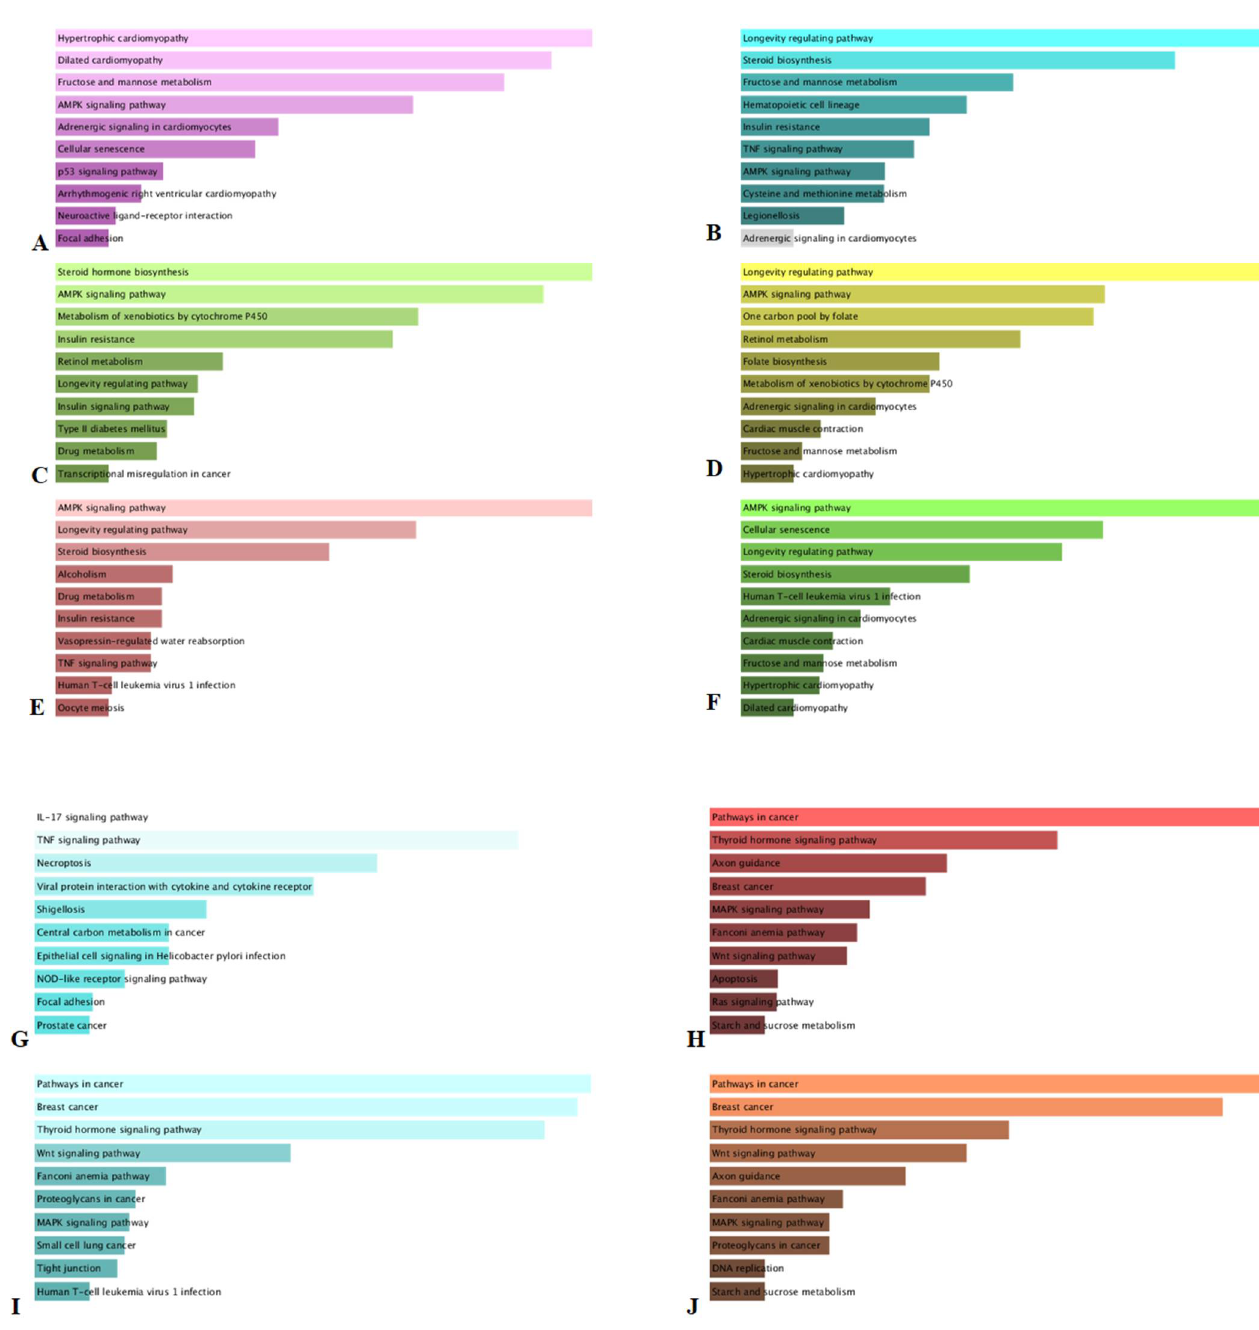
Figure 6. Top 10 KEGG pathway enrichment for the selected compounds. The bars in the panels represents the p - values computed using the Fisher exact test. The longer bars and lighter colored bars mean that the term is more significant. ( A ) artabsin; ( B ) dehydroleucodin; ( C ) dihydrosantamarin; ( D ) leucodin; ( E ) matricin; ( F ) tanaparthin peroxide; ( G ) neochlorogenic acid and chlorogenic acid; ( H ) homoorientin; ( I ) vitexin; ( J ) isovitexin.